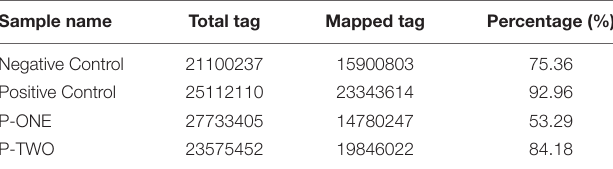
TABLE 4 | Summary of detected tags for each sample.